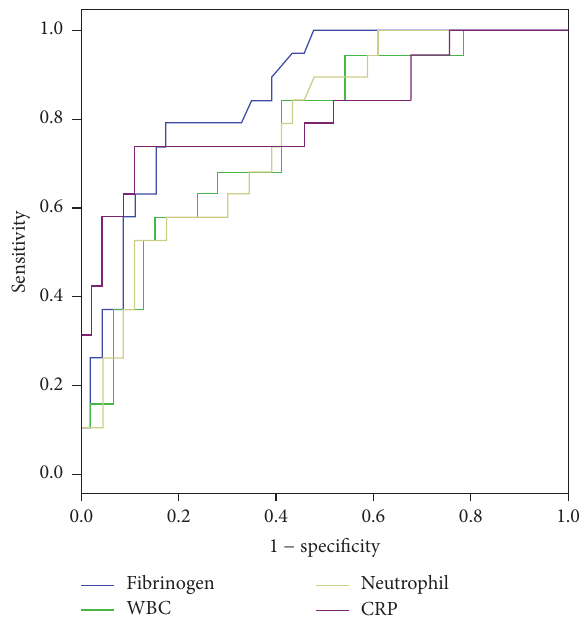
Figure 2: Receiver operating characteristic (ROC) curve of fibrino- genversusotherinflammationmarkersinpredictingamputationfor patients with DFU.